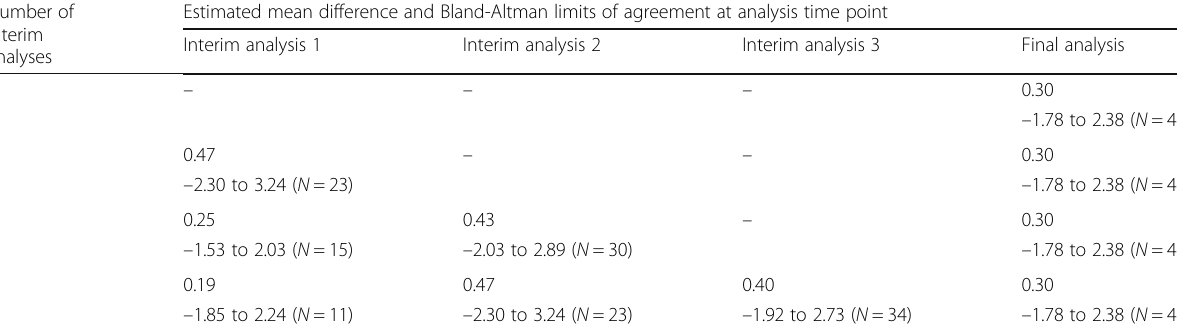
Table 1 Estimated mean difference and Bland-Altman limits of agreement for the paired differences of measurements Number of Estimated mean difference and Bland-Altman limits of agreement at analysis time point interim